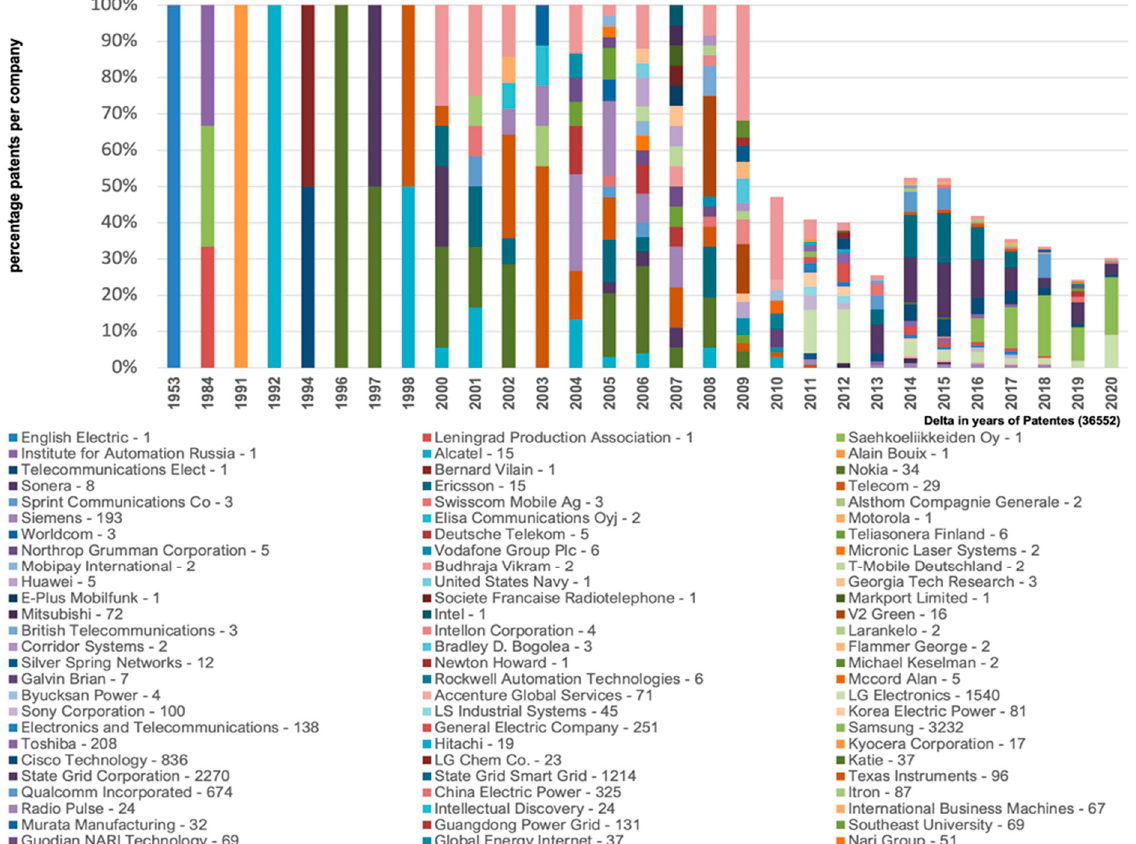
Figure 2. Percentage of patents related to Smart Grid in energy use.